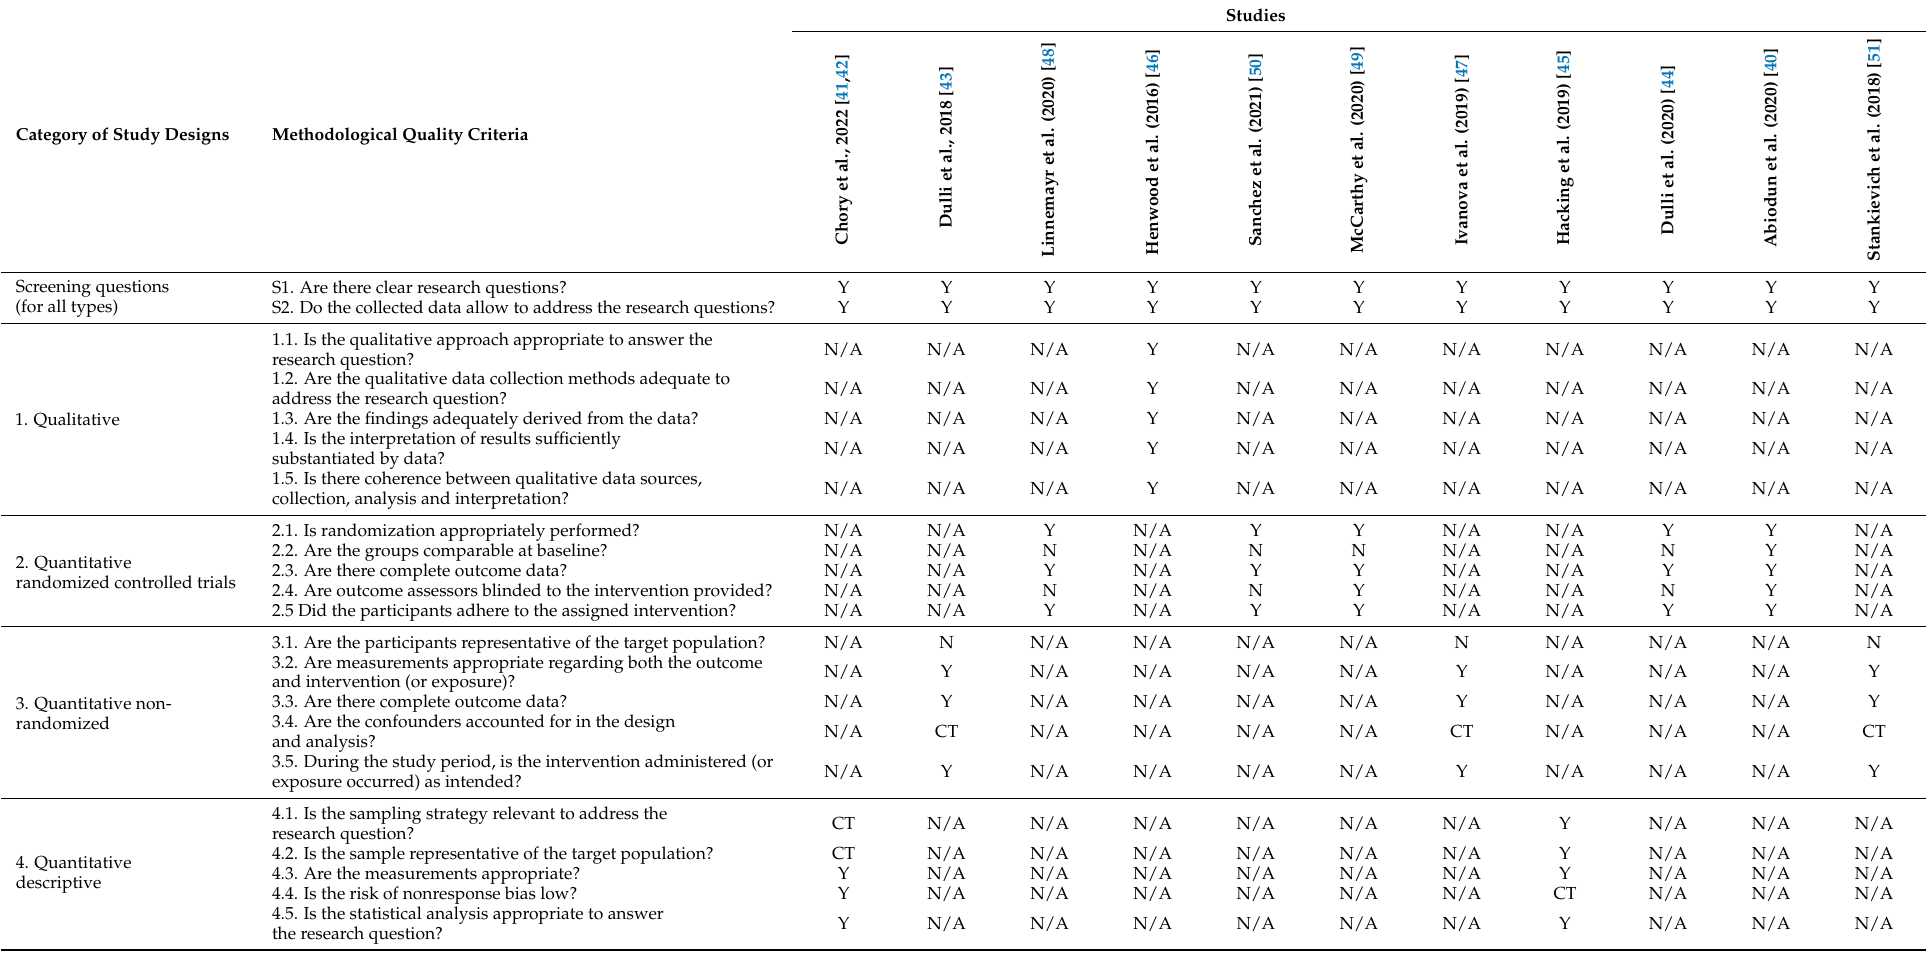
Table 2. MMAT Quality Assessment and Grading of